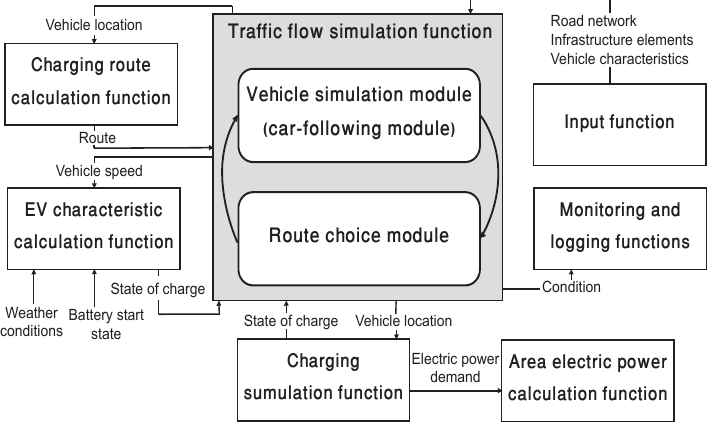
Figure 3. Schematic design of the CMS behavior